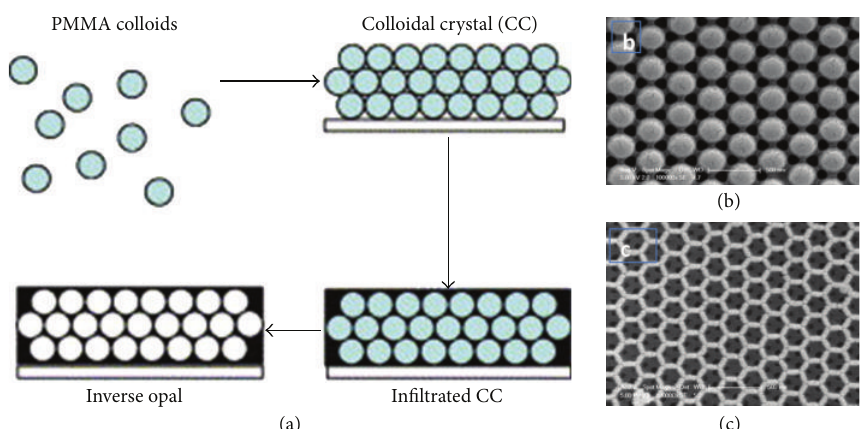
Figure 11: Fabrication scheme of an inverse opal (a); poly(methyl methacrylate) colloidal spheres (b); TiO 2 inverse opal (c) [9].